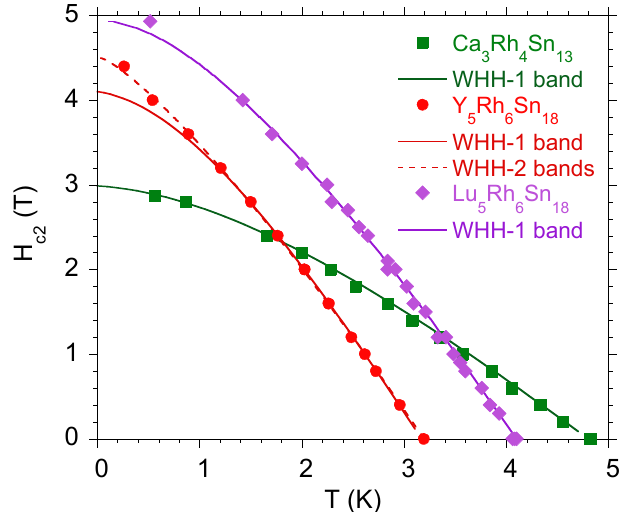
Figure 5. The upper critical field H c 2 in the H − T plane for Ca 3 Rh 4 Sn 13 , Y 5 Rh 6 Sn 18 , and Lu 5 Rh 6 Sn 18 approximated by the one-band (solid line) and two-band (dotted line) Werthamer–Helfand–Hohenberg (WHH)